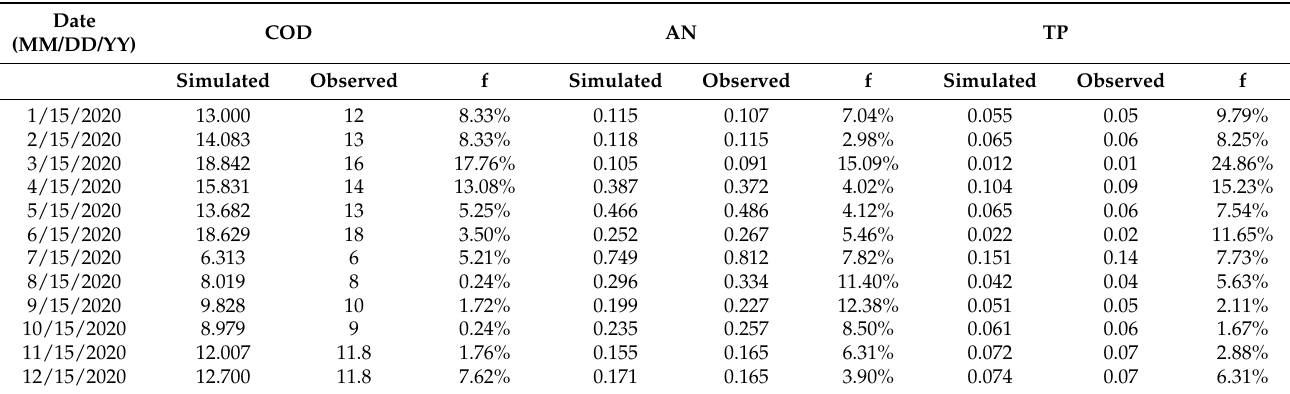
Table 14. Error analysis of simulation results